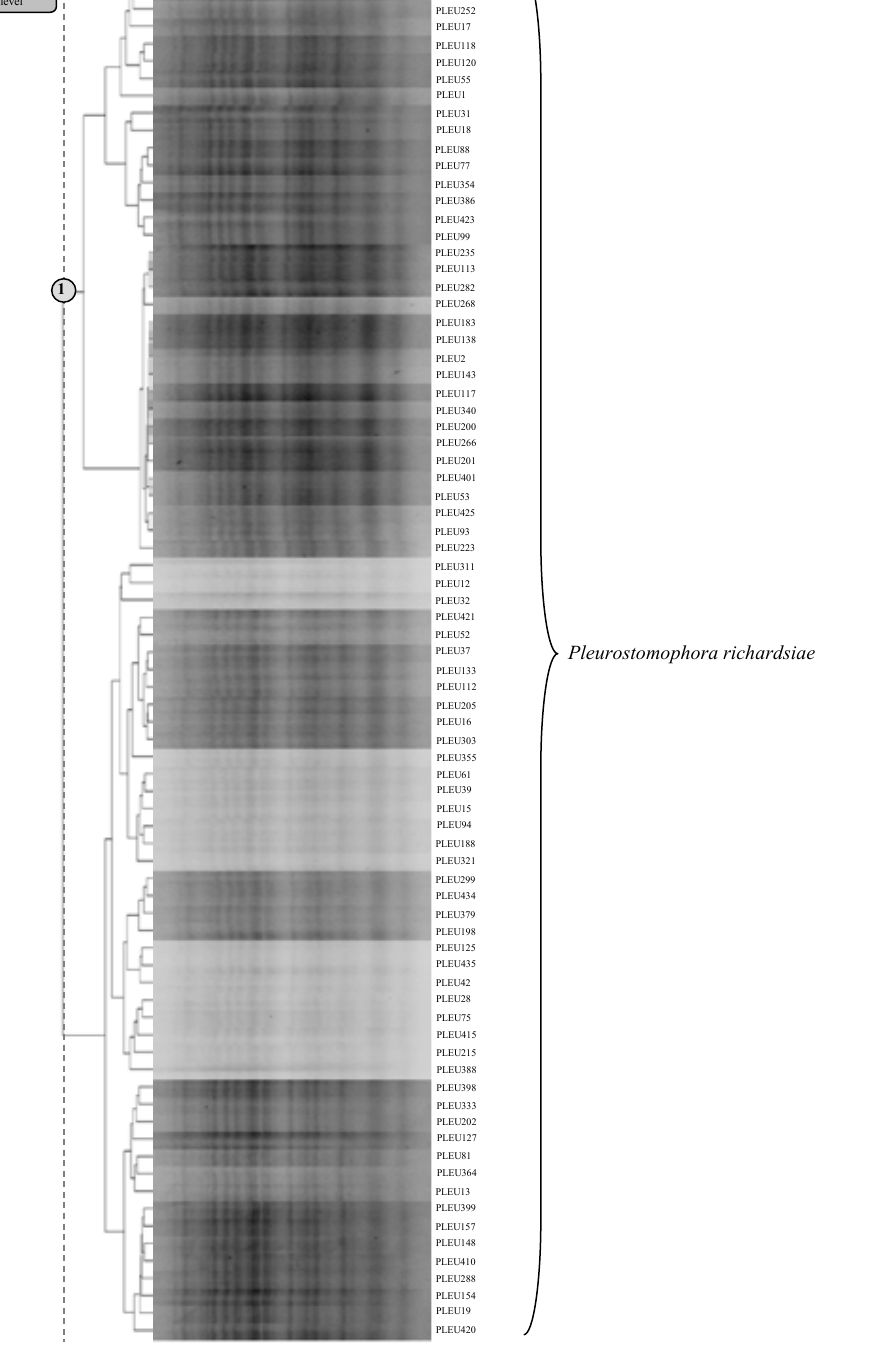
Figure 2. Consensus cladogram from MSP-PCR profiles obtained with primer M13. The vertical dashed line corresponds to the reproducibility level (90%) from which one cluster of isolates is inferred (indicated by numbered